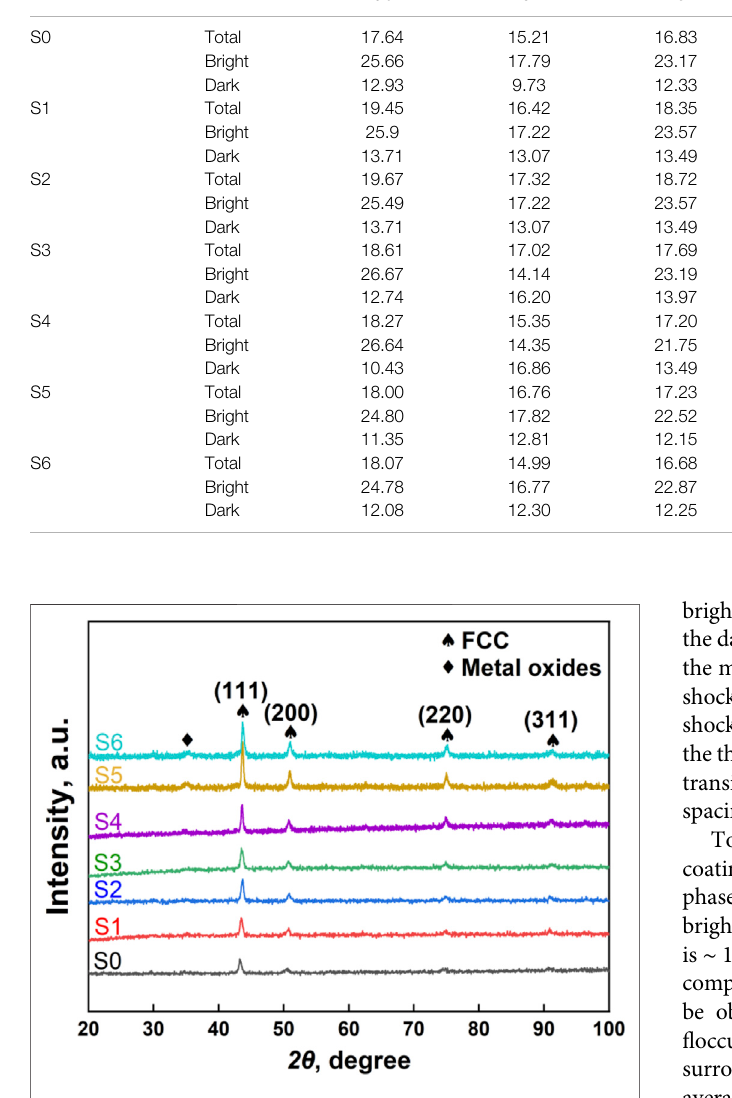
TABLE 2 | Chemical compositions of different regions in the CoCrFeNiMn HEA coatings by EDS (at.%). Samples Regions Chemical composition (at. %) Phases Co S0